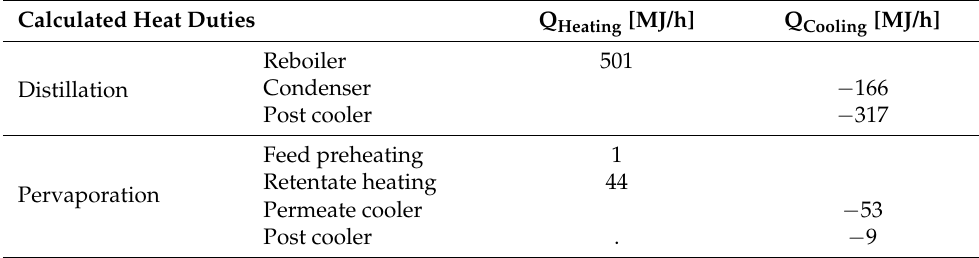
Table 6. Calculated heat duties of the hybrid Table 6 . Calculated heat duties of the hybrid system .